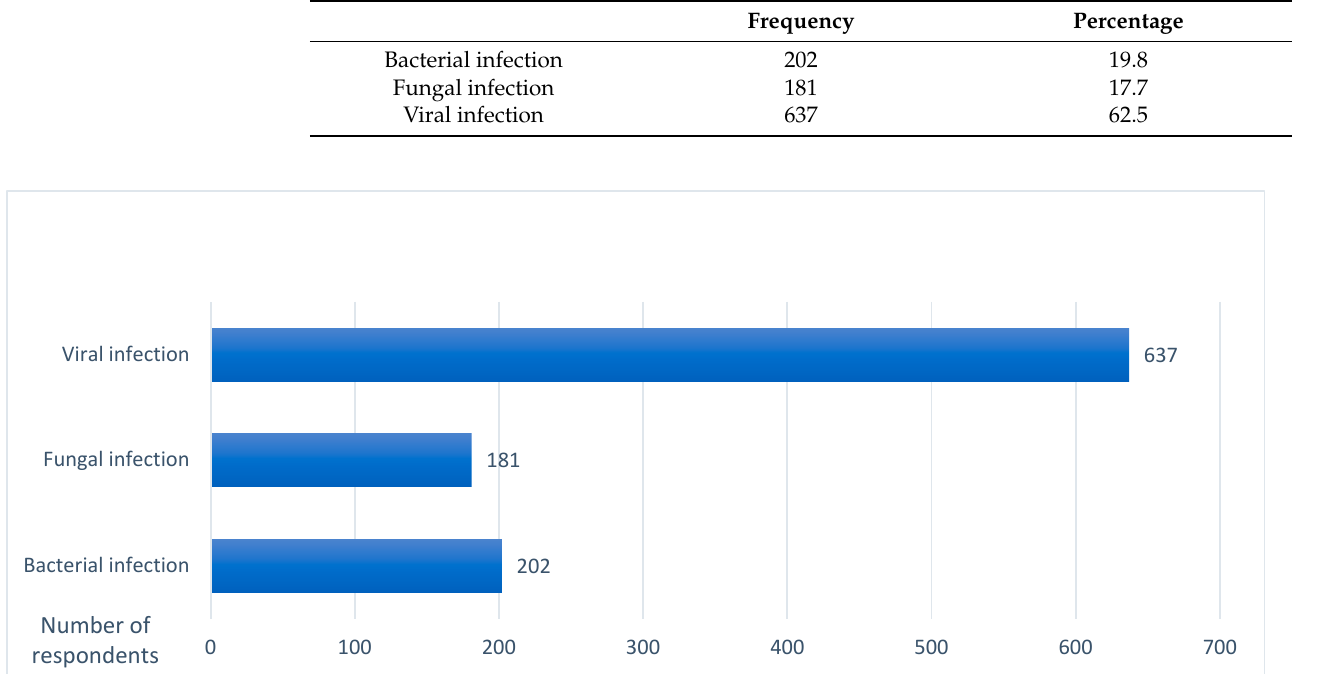
Figure 1. Public perceptions regarding the types of monkeypox disease (viral, fungal,